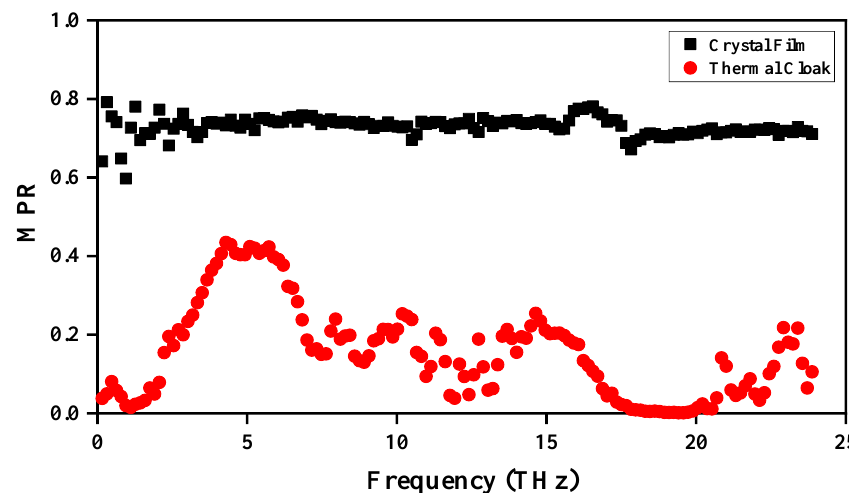
Figure 8. MPR in the calculated region of the different structures.